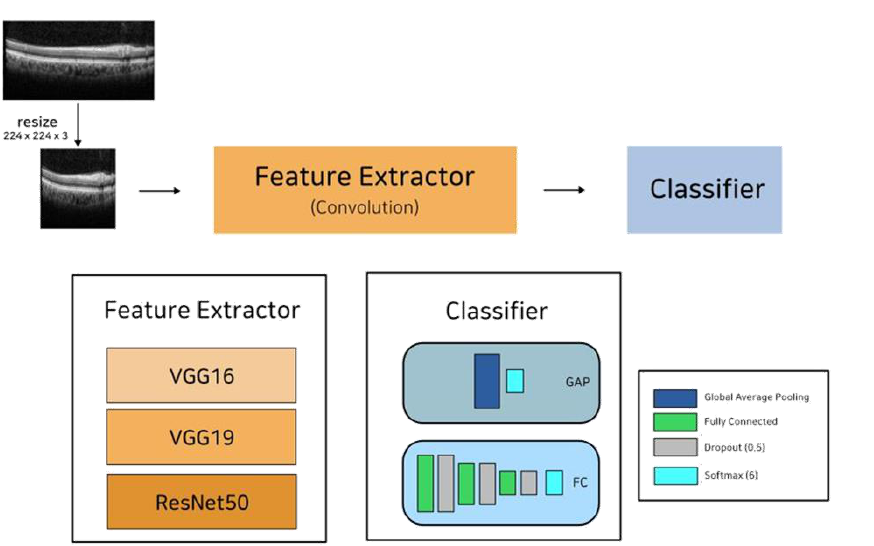
Figure 2. The input image is an SD – OCT image. First, the input image is resized to 224 × 224 × 3. Then, the resized image is given to the feature extractor layer. Finally, features extracted using the feature extractor are passed to the classifier layer for final classification.